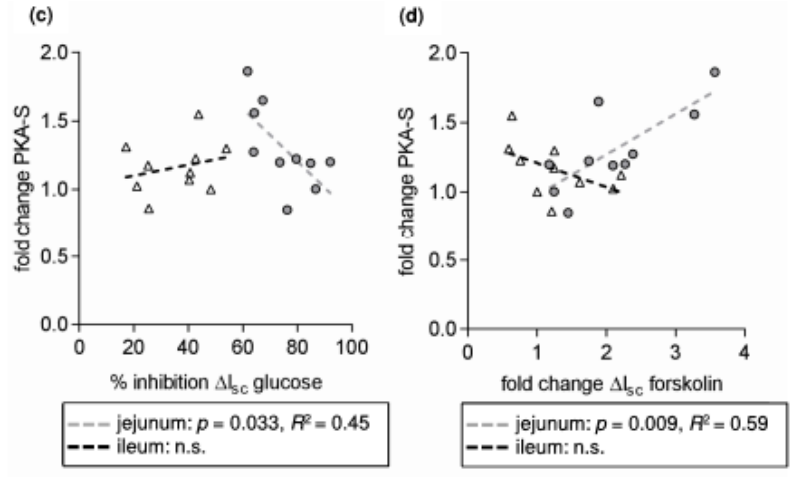
Figure 6. Correlation analysis of the relative changes in protein phosphorylation levels expressed as fold change of resveratrol-treated samples compared to control samples and results from Ussing chamber studies ( a ) fold change in pSGLT1/SGLT1 vs. percent inhibition of glucose-induced ∆ I sc ( b ) fold change in pAMPK/AMPK vs. percent inhibition of glucose-induced ∆ I sc ( c ) percent inhibition of glucose-induced ∆ I sc vs. fold change in the amount of phosphorylated PKA substrates (PKA-S) ( d ) fold change in forskolin-induced ∆ I sc vs. fold change in PKA-S. n = 10.